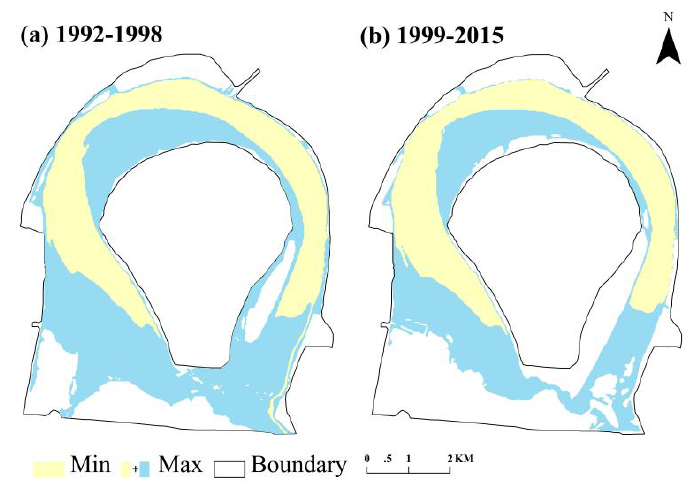
Figure 5. Temporal changes in water level and water surface areas during the flood and non-flood seasons of the Tian-e-Zhou oxbow lake from 1992–2015. ( a , d ) show the total water level and the water